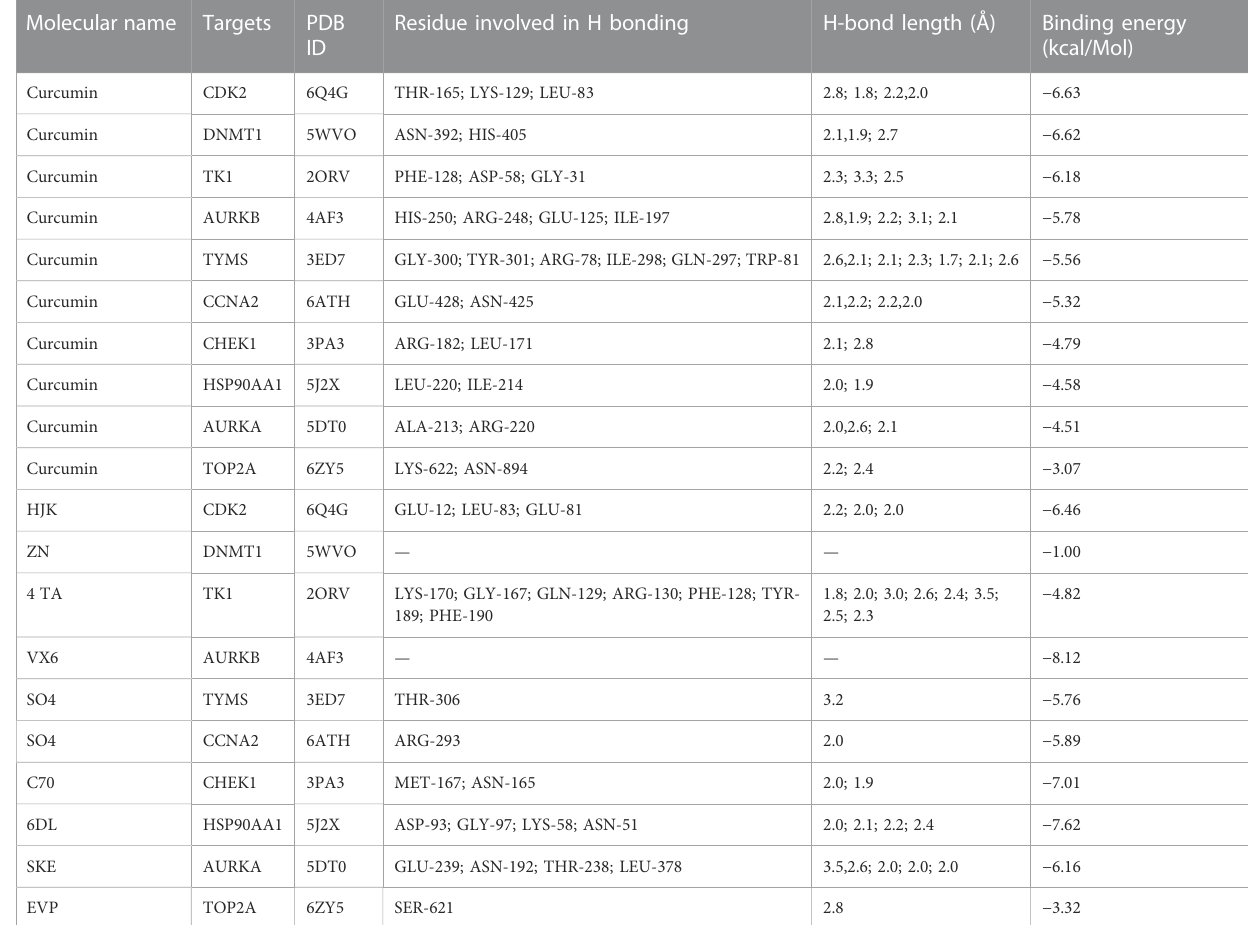
TABLE 5 Basic information on the molecular docking of curcumin and target proteins. Molecular